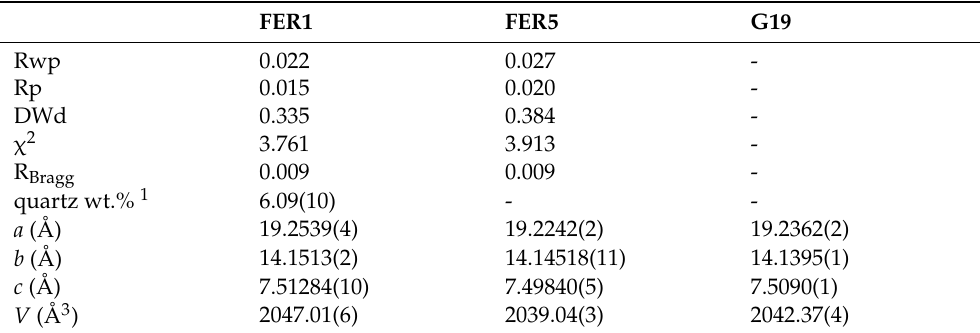
Table 4. Miscellaneous data of the refinements. Statistic indicators as defined in [24]. Data of ferrierite (G19) from Giacobbe et al. [22] are reported for comparison.